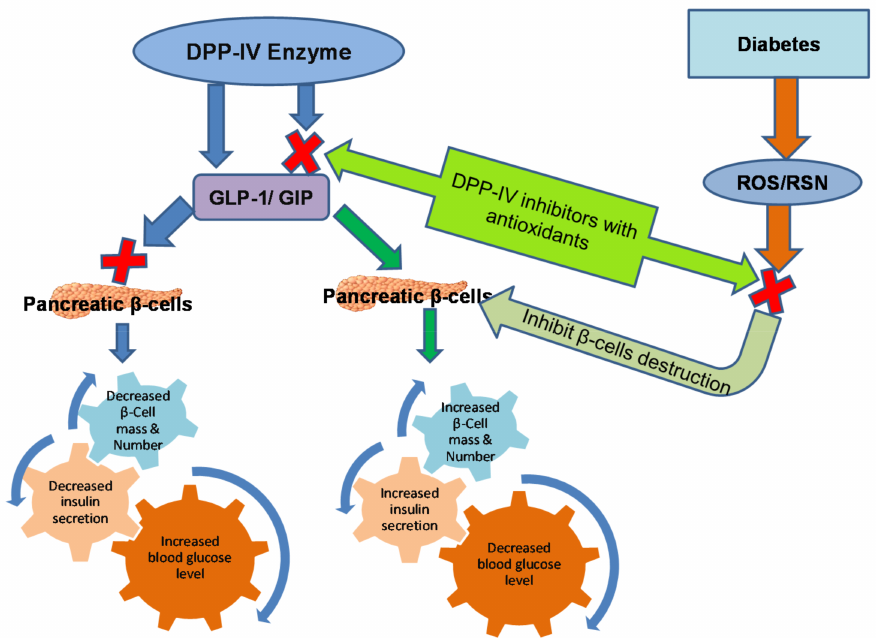
Figure 3. Role of DPP-IV inhibitors on GLP-1 dependent and independent manner during oxidative stress. Abbreviations: dipeptidyl peptidase-IV (DPP-IV), glucagon-like peptide-1 (GLP-1), Reactive Oxygen Species (ROS), Reactive Nitrogen Species (RNS).